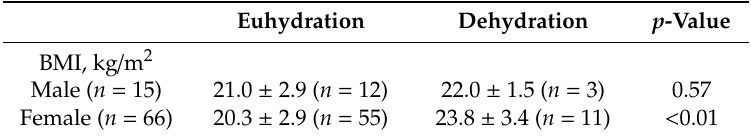
Table 3. BMI di ff erences between euhydration and dehydration stratified by sex.